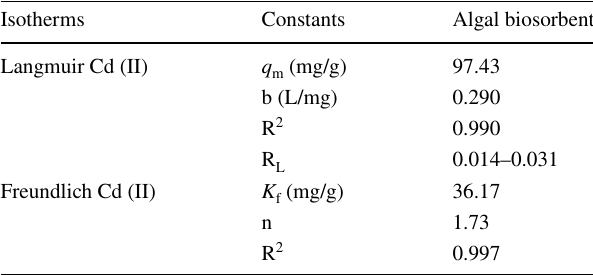
Table 5 Langmuir and Freundlich adsorption isotherm constants and parameters for adsorption of Cd (II) on algal